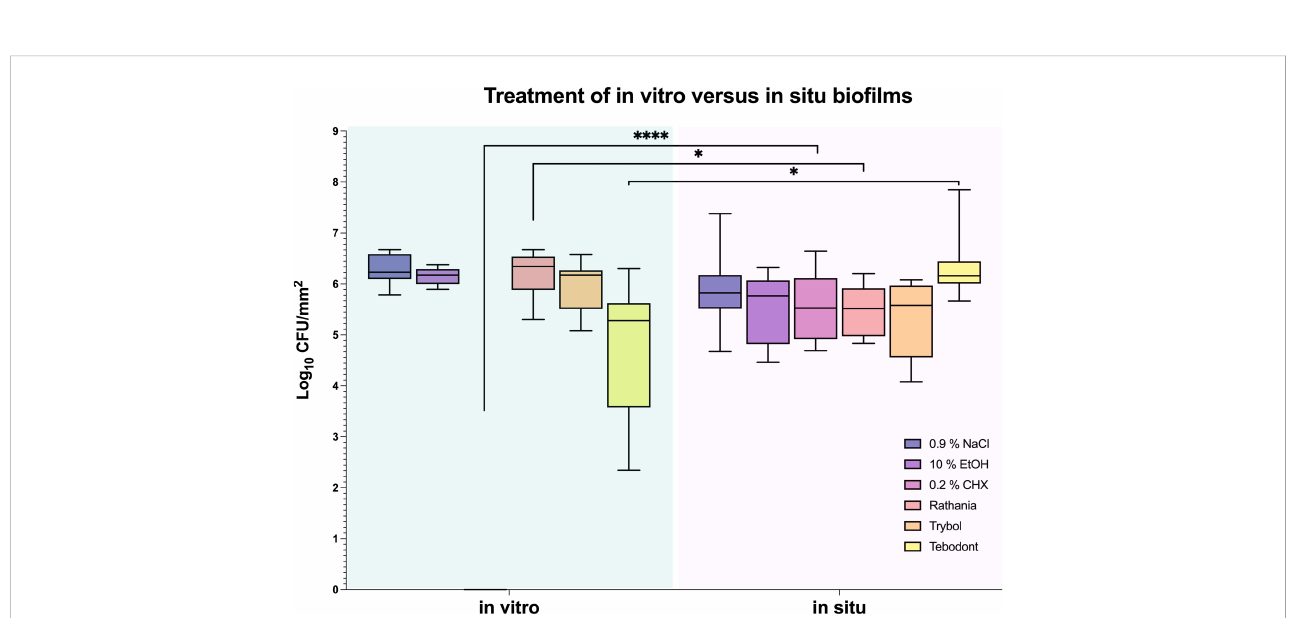
FIGURE 5 Box plots illustrating the comparison between the two treatment methods in vitro and in situ . It was measured by colony-forming units (CFUs) on a log 10 scale per mm 2 (log 10 /mm 2 ). In vitro and in situ bio fi lms were treated with Ratanhia, Trybol, Tebodont. 0.2% CHX (positive control), 0.9% NaCl and 10% EtOH (negative control) were also used. The line dividing the box shows the median. The p-values of the signi fi cantly different data are plotted: *= P- value <0.05, **** = P-value <